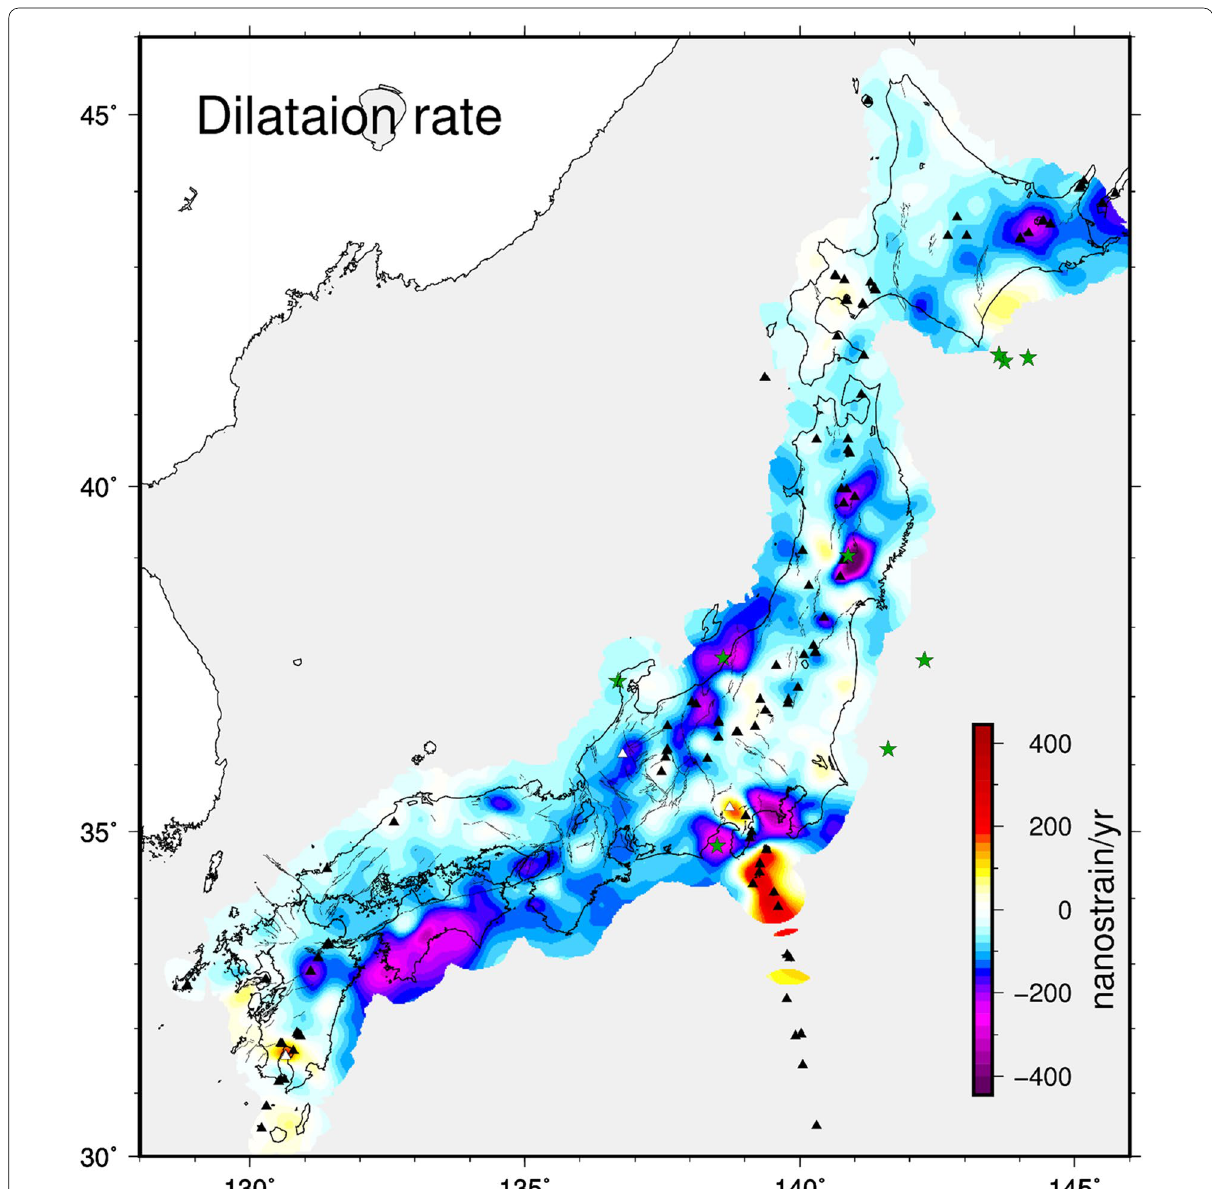
Fig. 16 The dilatation-rate field estimated from the ABIC method with L = 20 km. Green stars represent the epicenters of earthquakes whose coordinate offsets are removed from GNSS data. Black lines represent surface traces of major active faults (Headquarters for Earthquake Research Promotion 2017). White triangles represent Mt. Fuji, Hakusan and Sakurajima, and black triangles represent other active volcanos (JMA